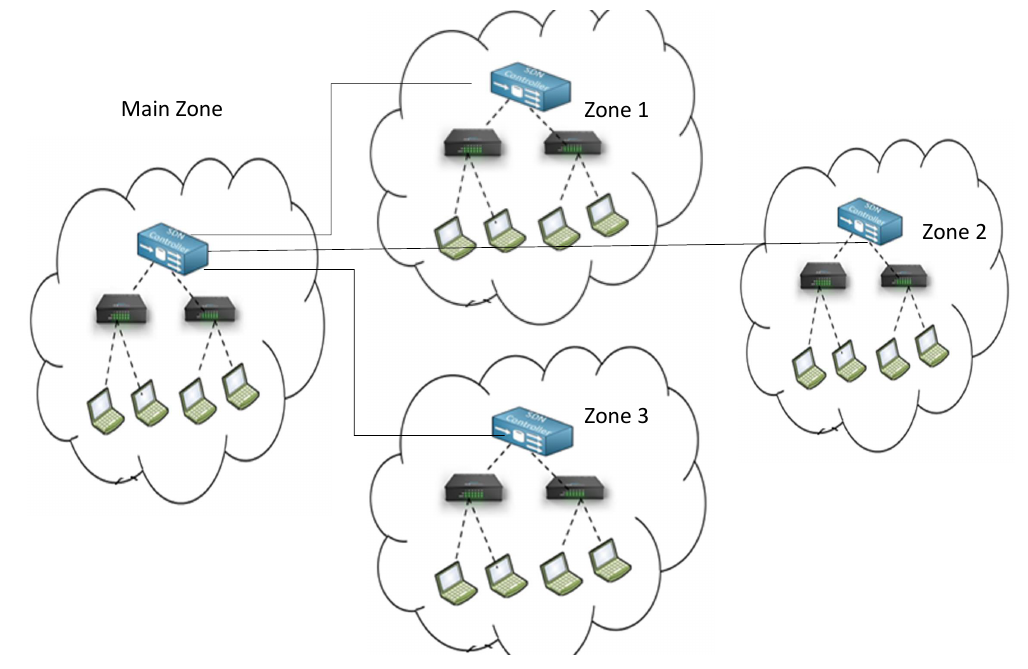
Figure 1. The FCR-NS architecture